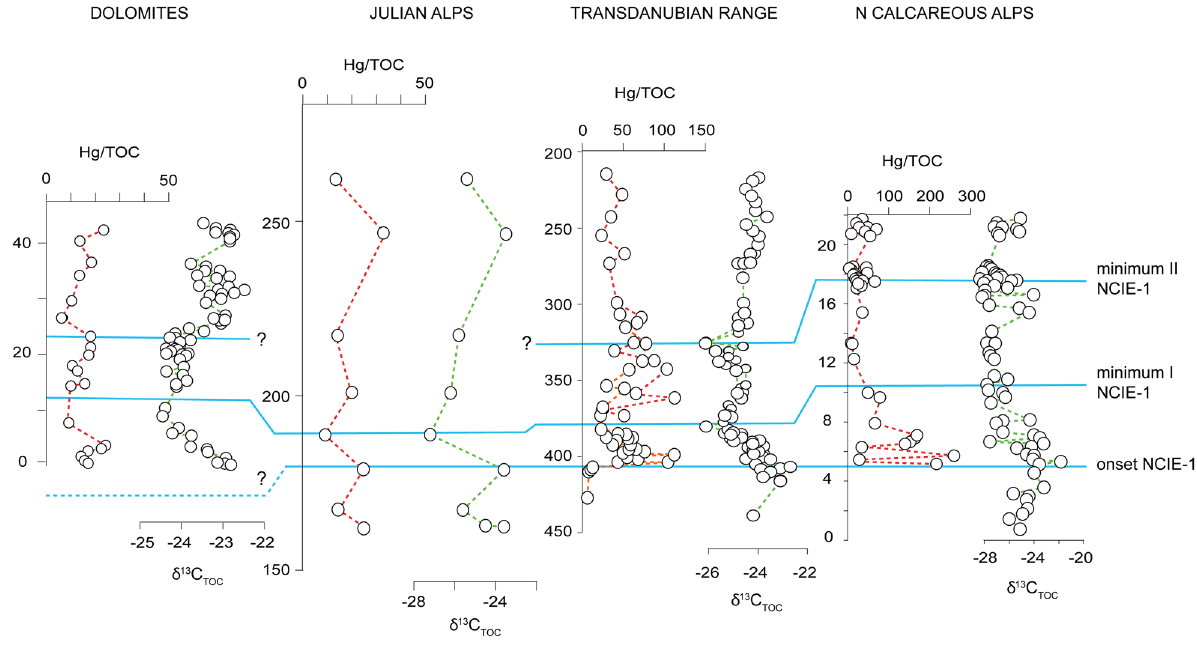
Figure 5. Detail of Hg/TOC and δ 13 C TOC data across the NCIE-1 in the studied basins of the Western Tethys. The Hg/TOC spike associated with the NCIE-1 of the CPE could be missing in the Southern Alps (Dolomites and Julian Alps) because of the incompleteness of the succession and lower sampling